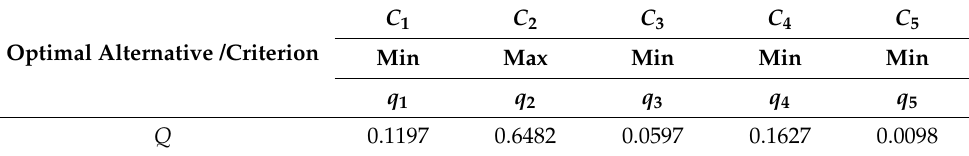
Table 13. Optimal alternative.